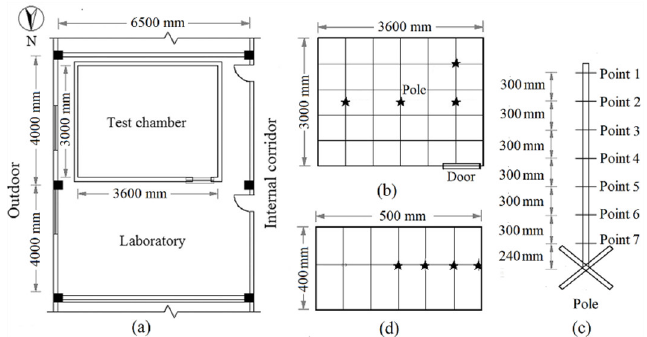
Figure 5. Schematic view of the experimental chamber: ( a ) its layout, ( b ) distribution of measuring poles, ( c ) distribution of measuring points and ( d ) measuring points of the sand box.